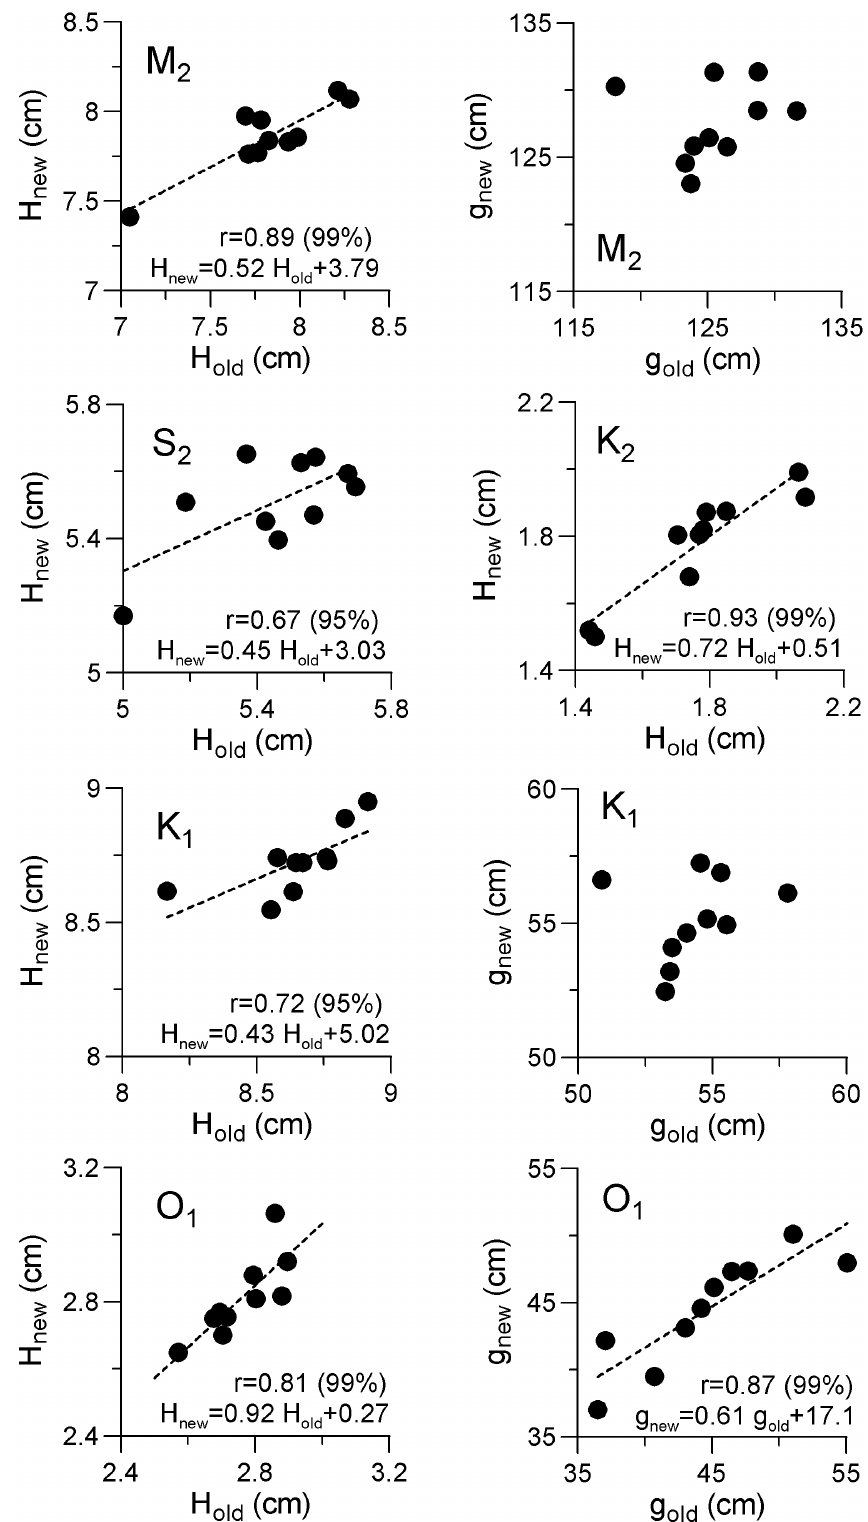
Fig. 6. Regression diagrams between the VAX-computed (H old , g old ) and AutoCAD-computed (H new , g new ) amplitudes and phases between 1986 and